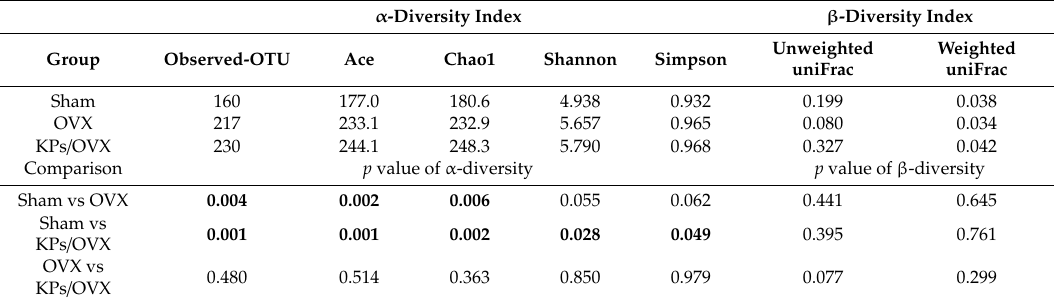
Table 1. The mean α - and β -diversity indices and the P values for various group